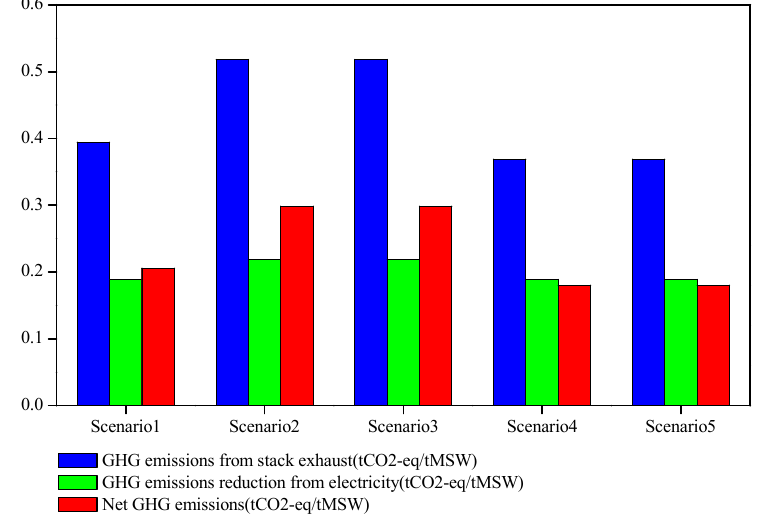
Figure 8. GHG emissions from MSW incineration under five scenarios.